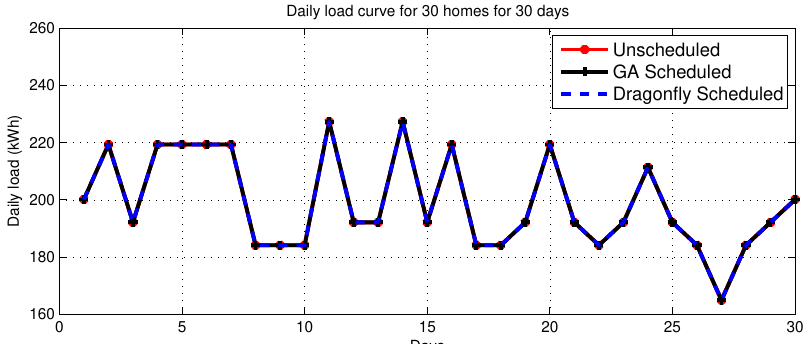
Figure 8. Daily load curve for un-scheduled and GA and DA scheduled load for 30 days.